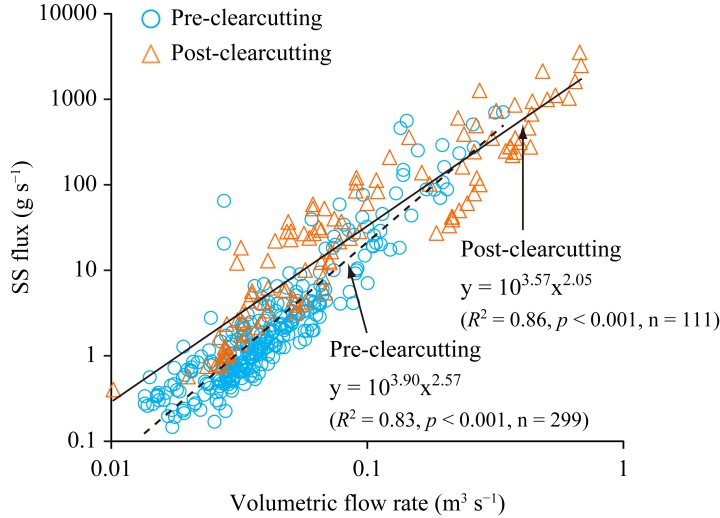
Comparison of measured suspended solids (SS) fluxes and volumetric flow rates in pre- and post-clearcutting periods.